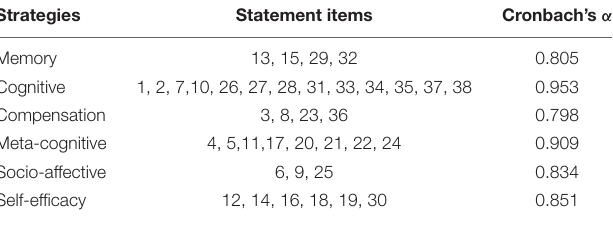
TABLE 4 | Classification of